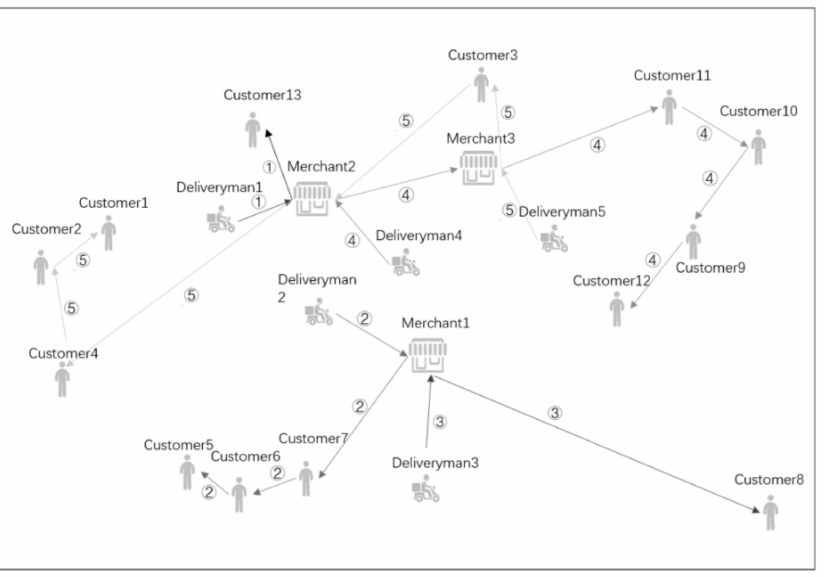
Figure 1. Logic diagram of the instant distribution